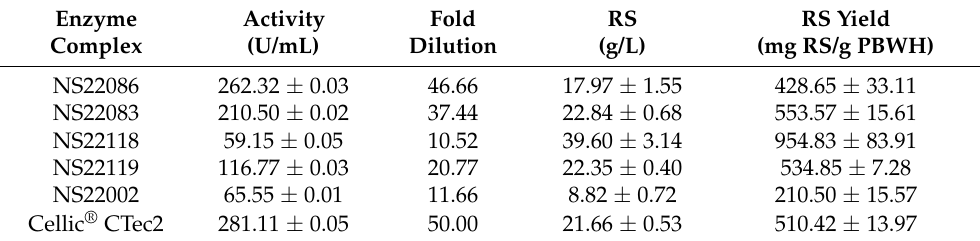
Table 5. Saccharification of pretreated biomass of water hyacinth (PBWH) by using Cellic ® CTec2, NS22118 and mixtures of Cellic ® Ctec2 and NS22118 at several dilutions. RS RS Enzyme Dilution (g/L) (mg/g PBWH) 1:10 21.48 ± 0.78 514.39 ± 15.88 1:50 17.42 ± 0.17 414.40 ± 1.13 Cellic ® CTec2 1:100 12.20 ± 0.06 292.31 ± 3.80 1:1000 5.88 ± 0.03 142.58 ± 0.62 1:10 38.47 ± 2.20 909.51 ± 58.60 1:50 2.06 ± 0.06 49.02 ± 0.24 NS22118 1:100 1.10 ± 0.04 26.12 ± 1.43 1:10 49.35 ± 4.04 1175.67 ± 84.57 Cellic ® CTec2 (1:50) + NS22118 1:50 26.00 ± 1.23 616.43 ± 29.09